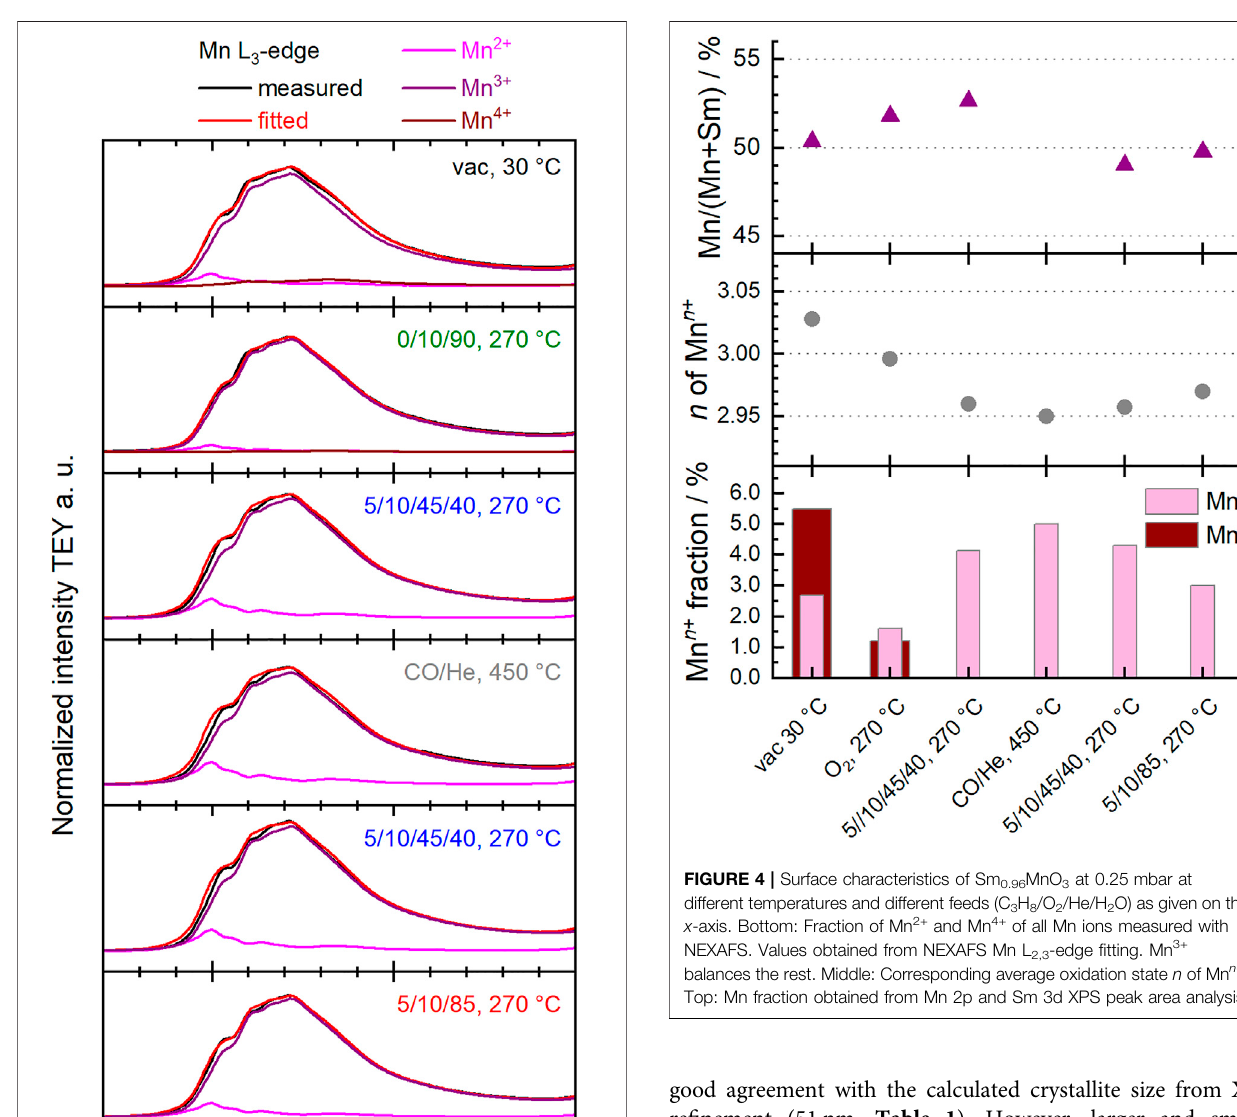
Frontiers in Chemistry |